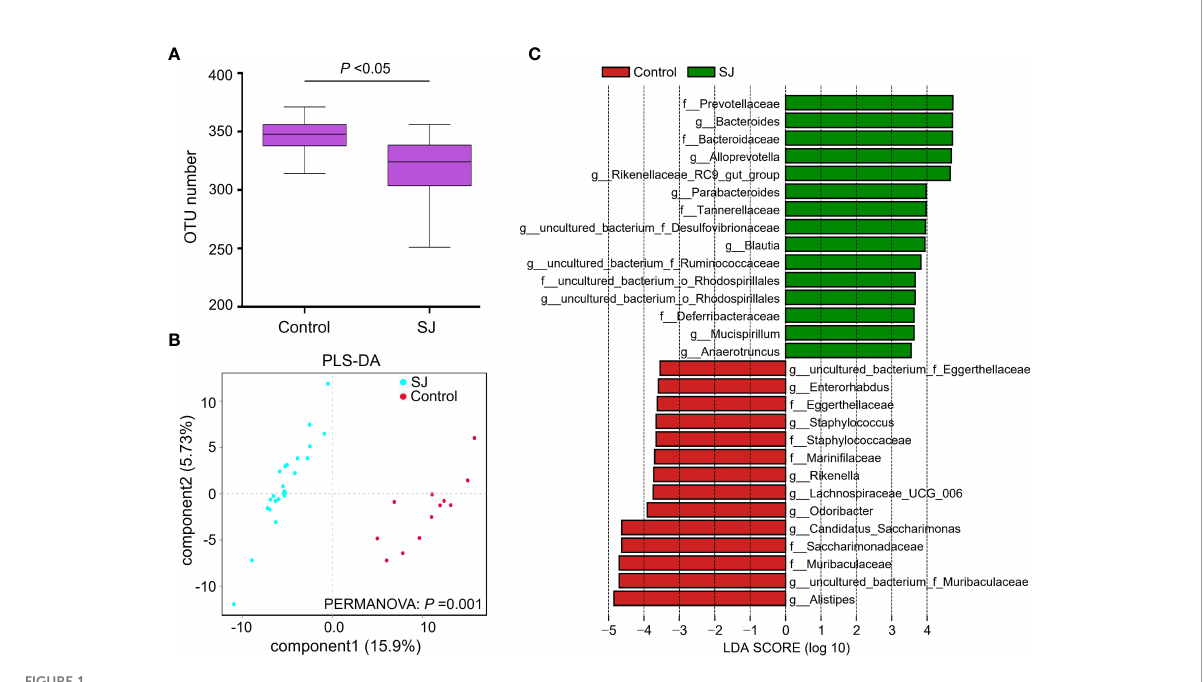
FIGURE 1 Comparisons of gut microbiota between S. japonicum -infected (n = 24) and uninfected (n = 12) mice. (A) OTUs analysis. (B) PLS-DA analysis. (C) Differential gut bacterial taxa were analyzed by LEfSe analysis with LDA score >3.5 between groups. Control: without S. japonicum infection mice. SJ; S. japonicum -infected mice. *P < 0.05 indicates signi fi cant